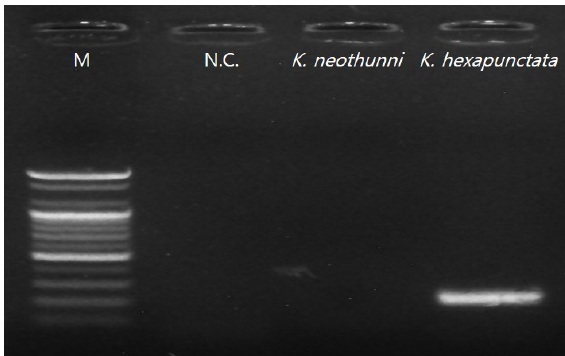
Figure 4. Electrophoresis results of secondary polymerase chain reaction (PCR) for distinguishing Kudoa neothunni from Kudoa hexapunctata (M = 2000 bp marker; N.C. = negative control).